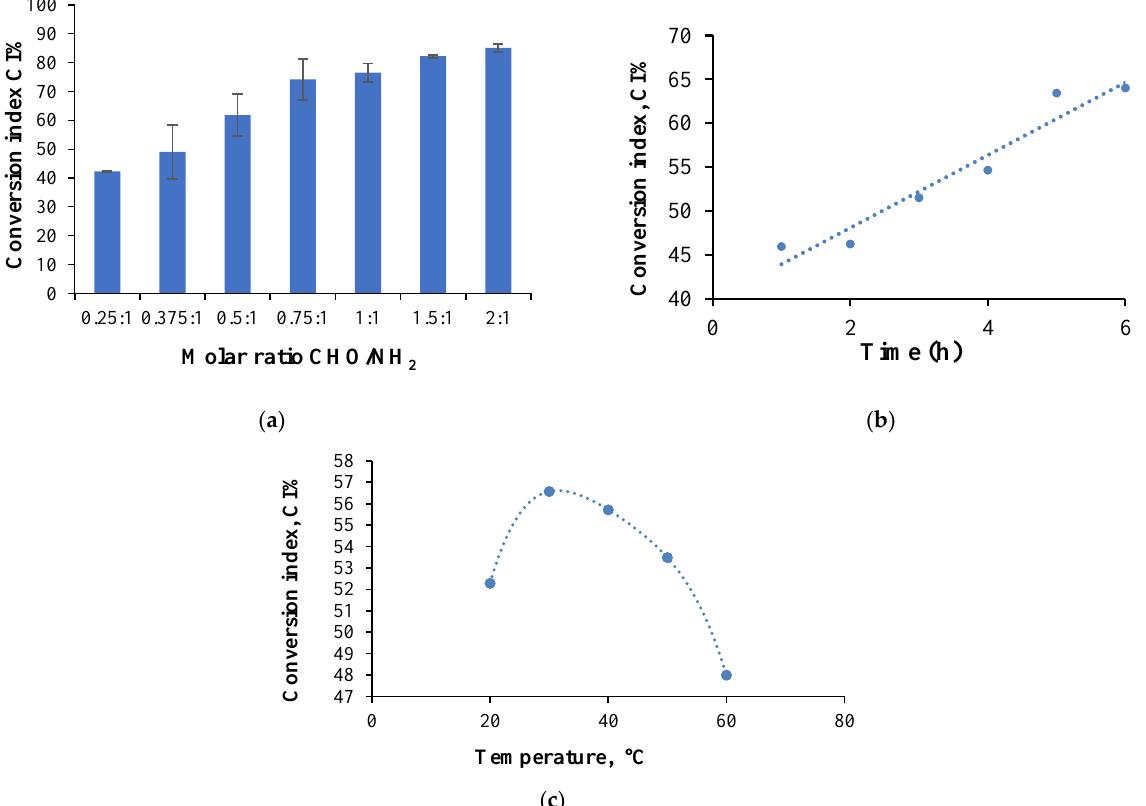
Figure 8. The variation of the amino groups’ conversion index values by studying the cross-linking reaction influencing factors such as ( a ) the molar ratios influence (t reaction = 2.5 h; T reaction = 55 °C, pH = 2.4—it was determined for all the samples ( b ) variation of CI values as a function of cross-linking time for P2 sample (T reaction = 55 °C, molar ratio CHO: NH 2 = 0.375:1, pH = 2.4); ( c ) variation of CI as a function of cross-linking temperature for P2 sample (T reaction = 55 °C, molar ratio CHO: NH 2 = 0.375:1, pH = 2.4).